Question: Compose a caption that would accompany this figure in a paper.
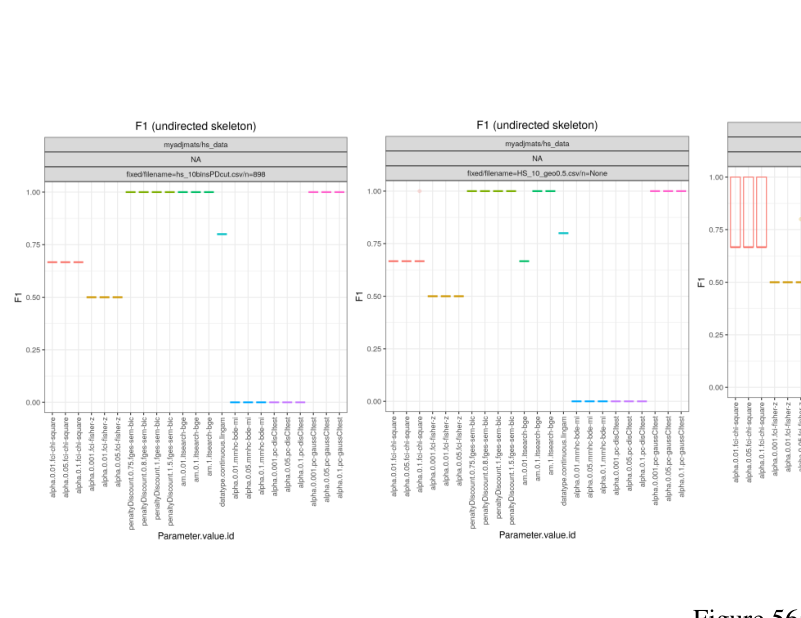
Answer: F1 Scores on the Human Stature data set. Dis- cretized, no noise.